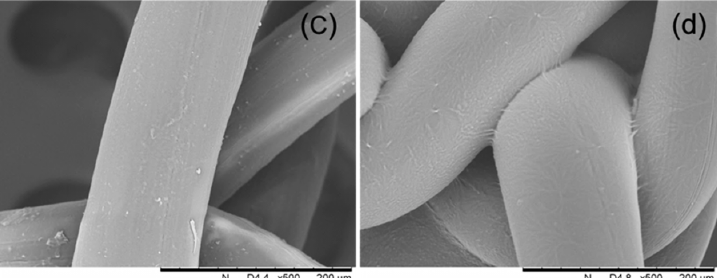
Figure 3. Scanning electron microscopy (SEM) images: ( a ) PP-untreated, ( b ) oxygen plasma-treated, ( c ) chitosan of low molecular weight (CH-LMW)-coated PP meshes, and ( d ) chitosan of medium molecular weight (CH-MMW) and levofloxacin HCl-coated PP meshes. All samples were scanned at a magnification of 500 × .